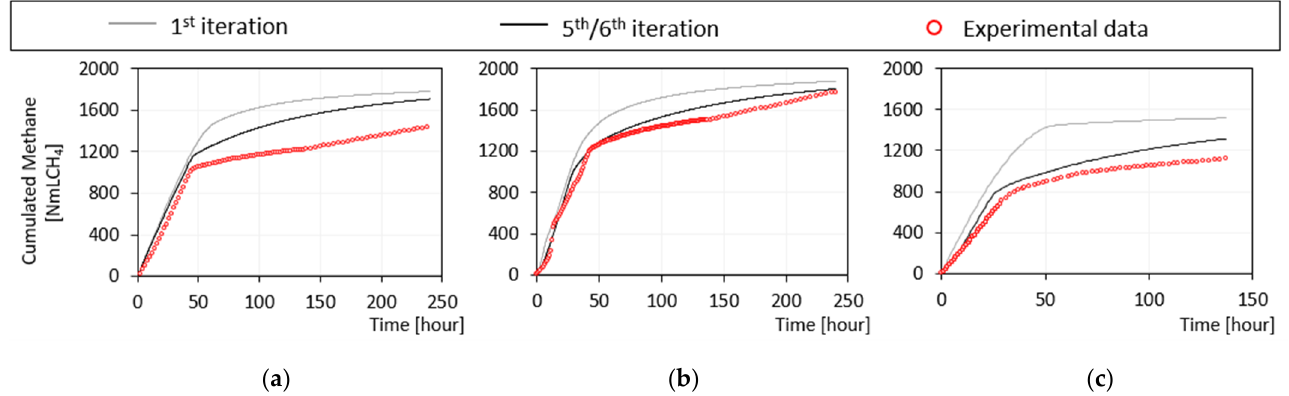
8 of 16 Table 1. Kinetic parameters estimated at first and last iterative step of the calibration process. Iteration